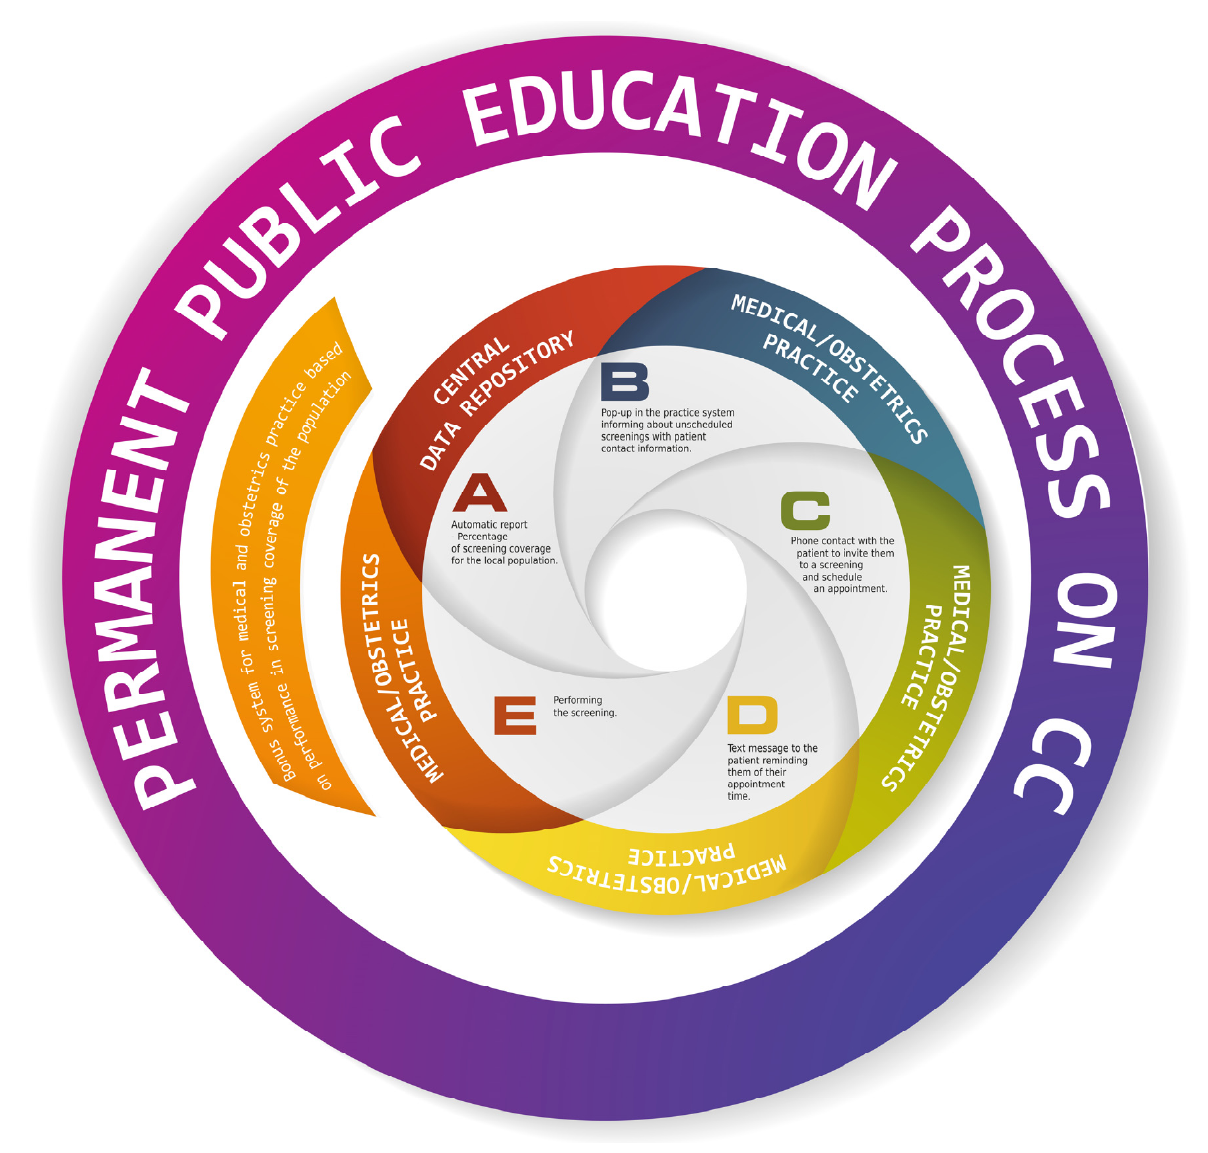
Figure 4. Recommended model for cervical-cancer-screening system operation.